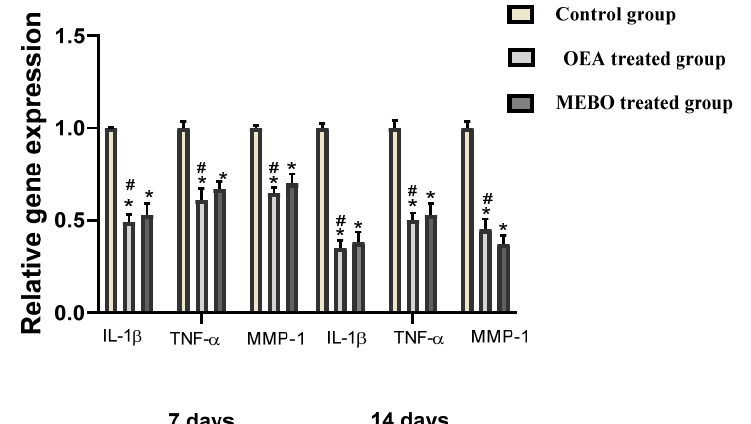
Figure 10. Gene expression in wounded rabbit tissues from several groups. qRT–PCR was utilized to assess gene expression in wounded tissues. After normalization to GAPDH, the data represented as fold change relative to the control group. The bars represent the mean ± SD. To determine whether there was a significant variation between studied groups, a one-way ANOVA test was utilized, with * p < 0.05 comparing to the control group on that day and # p < 0.05 comparing to the MEBO ® treated group on the same day.